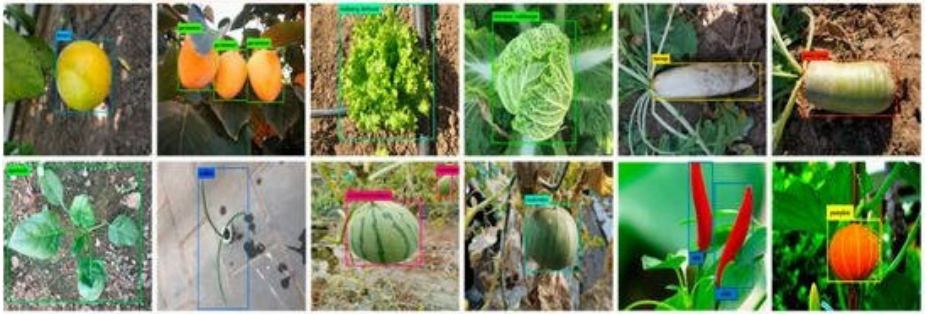
Figure 2. Examples of images from the CropDeep dataset.